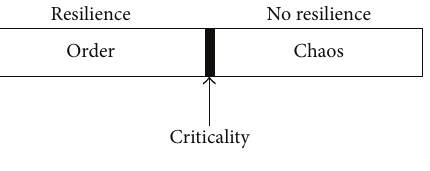
Figure 10: Self-organized criticality.